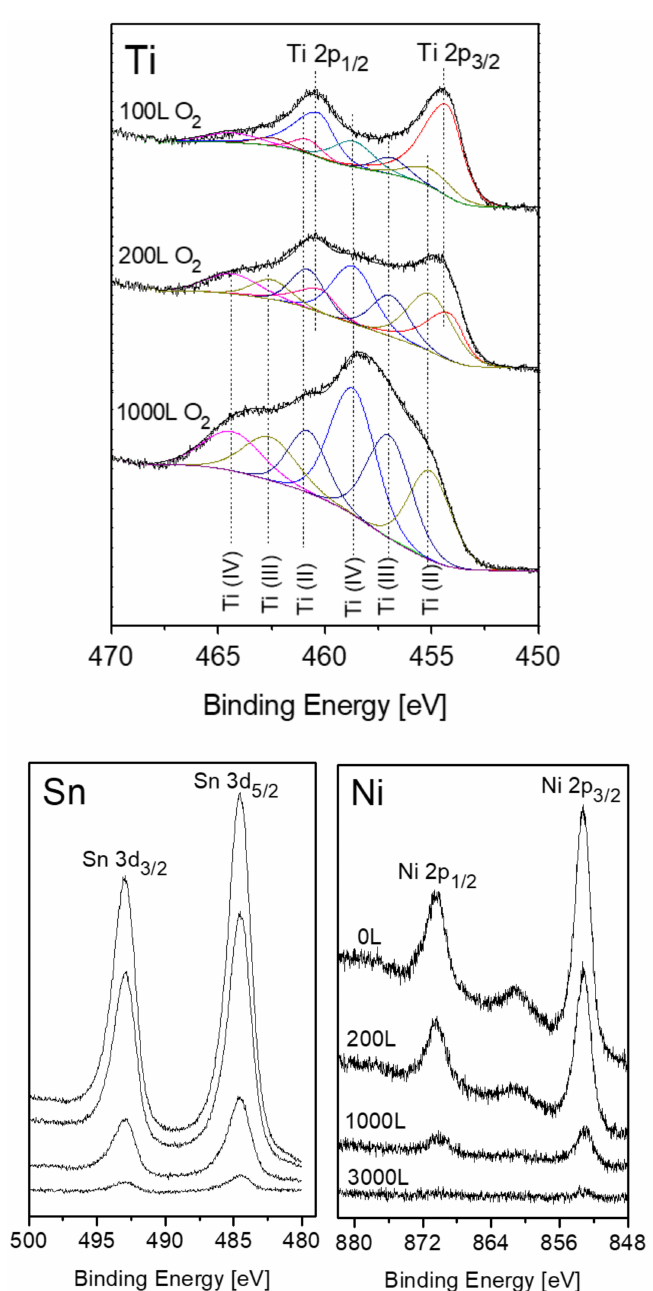
Figure 7. Representative XPS spectra of Ti, Ni and Sn after exposing to oxygen at 1000 K. Sn and Ni were exposed to identical amounts of oxygen. The order of the Sn spectra corresponds to the amount of oxygen exposure noted in the Ni